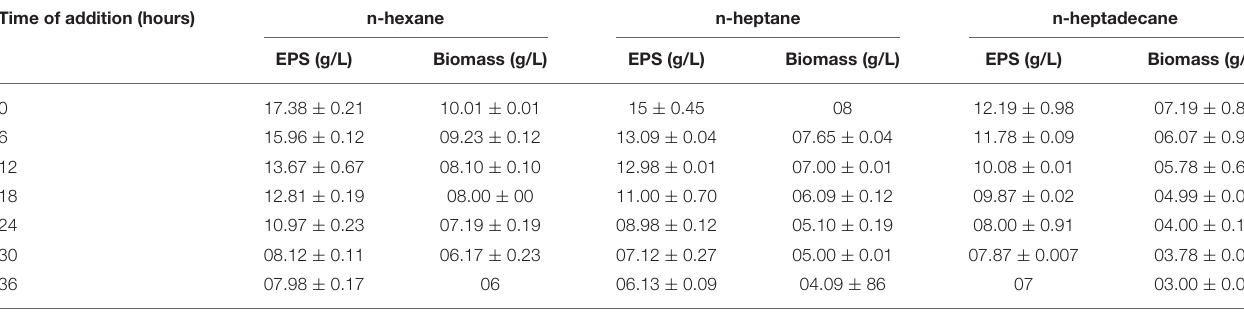
TABLE 3 | Effect of oxygen vectors (n-hexane, n-hexadecane, n-heptane) on EPS yield. Time of addition (hours)